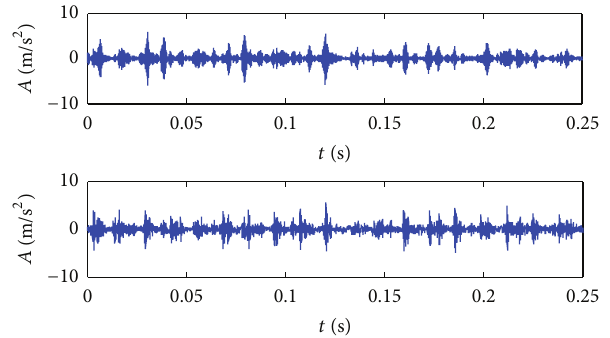
Figure 5: Signals after BSS and NSP processing.